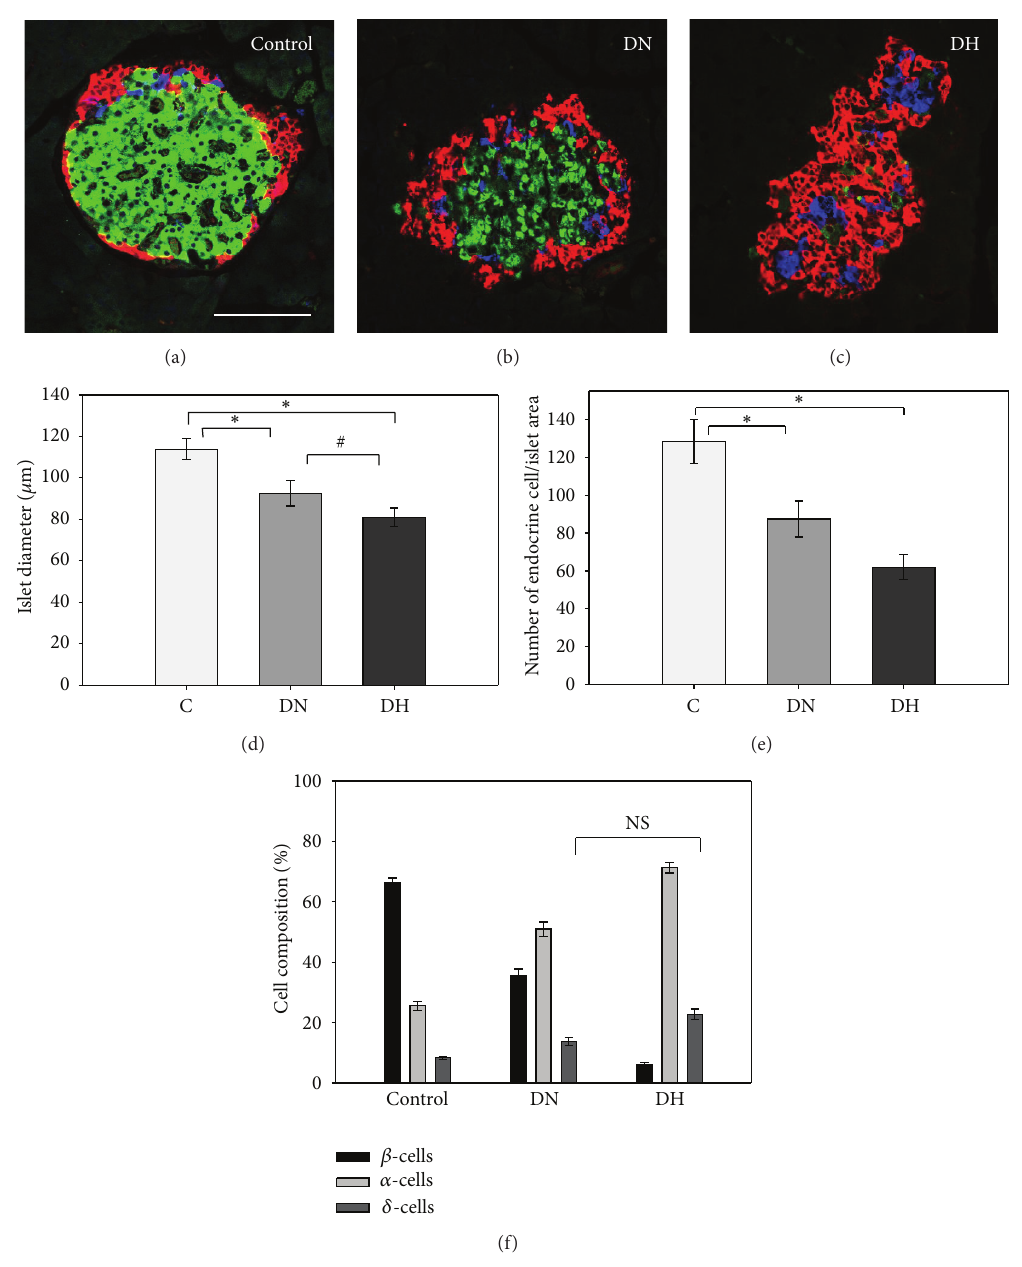
Figure8:IsletsizeandcellcompositioninSTZ-treatedrats.(a)AnisletfromnondiabeticDAratwaslargewithanormalcellularmorphology. Scale bar = 100 𝜇 m for all images. (b) A representative islet from a normoglycemic STZ-treated rat was smaller, but still maintained the 𝛽 -cell core (green) with the 𝛼 - (red) and 𝛿 -cells (blue) rim. (c) Typical islet from hyperglycemic rat was smaller than the other 2 groups with few 𝛽 -cells. (d) Islet diameter was plotted, and each group was more statistically different than the others. (e) The number of cells per islet area was less in the 2 STZ-treated groups (DN and DH) compared to controls. (f) Cell composition was plotted showing a loss of 𝛽 -cells with hyperglycemia. Cell composition from each of the 3 groups was different for each cell type except for the 𝛿 -cells between the DN and DH groups (NS = not significant). 𝑁 of islets = 96 from 3 controls, 73 from 3 DN rats, and 74 in the DH group (3 rats).